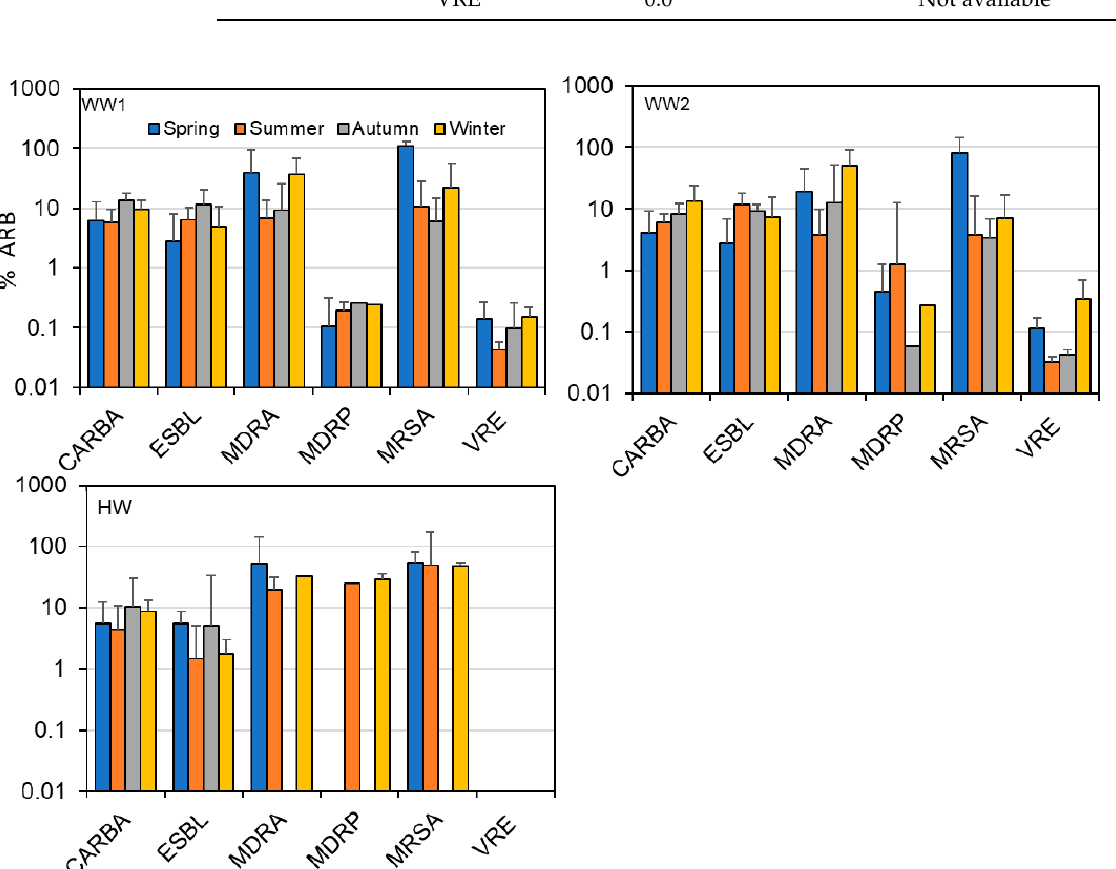
Figure 2. Percentage ARBs detected in each season from WW1, WW2, and HW during one year monitoring study in Sendai. Table 1. Detection rate of each ARB and its geometric mean of %resistance during the one-year